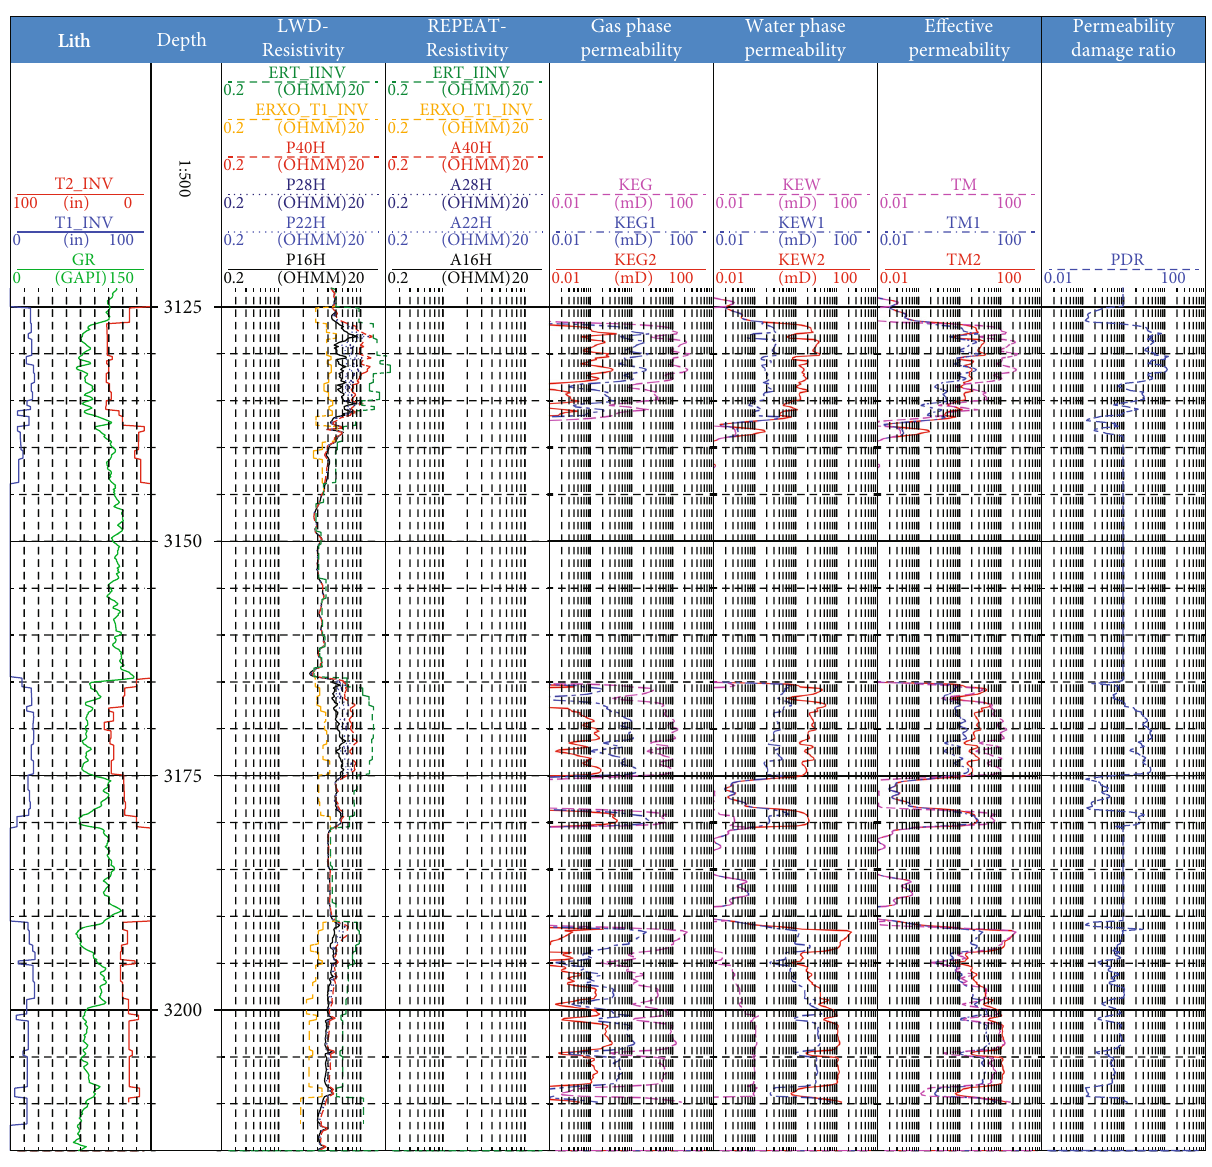
Figure 11: E ff ective permeability and permeability damage results of well